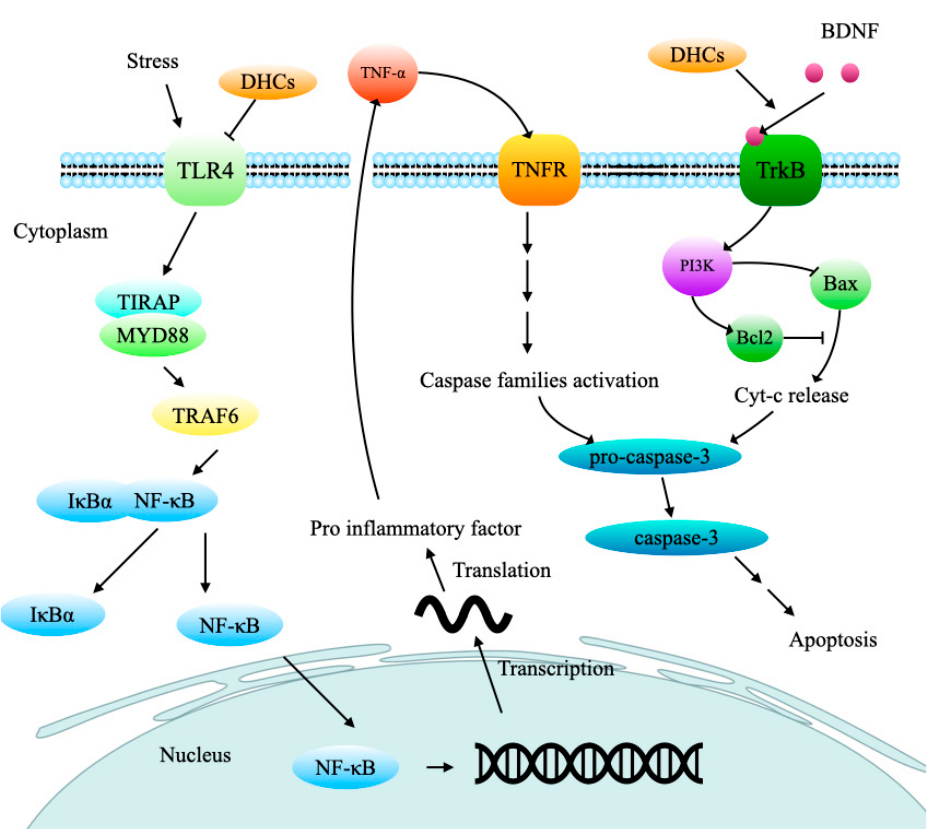
Figure 5. DHCs exert neuroprotective effects through their anti-inflammation and anti-apoptosis. TLR4, Toll-like receptor 4; TIRAP, toll/interleukin 1 receptor domain-containing adaptor protein; MYD88, myeloid differentiation factor 88; TRAF6, TNF receptor-associated factor 6; I κ B α , inhibitor of NF- κ B; NF- κ B, nuclear factor κ -B; TNF- α , tumor necrosis factor α ; TNFR, tumor necrosis factor receptor; BDNF, brain-derived neurotrophic factor; Trk B, tyrosine kinase receptor B; PI3K, phosphatidylinositol 3- kinase. Arrow ( → ) indicates activation, and the blunt arrow (– | ) indicates inhibition. The experiment showed phloridzin could significantly elevate the brain-derived neu- rotrophic factor (BDNF) level and reduce the acetylcholinesterase (AChE) activity in the hippocampus and cortex of the lipopolysaccharide (LPS)-treated mice [61]. BDNF can bind to tyrosine receptor kinase B (Trk B), which activates phosphatidylinositol 3-kinase (PI3K), and then spurs the anti-apoptosis and protein synthesis [64]. AChE can degrade acetylcholine and terminate the excitatory effect of neurotransmitters on the postsynaptic membrane, and reduced AChE levels can inhibit neuron damage and prevent AD forma- tion. A large amount of AChE was expressed when cells were in the state of apoptosis. The increased AChE protein can not only inhibit cell growth but also enter the nucleus